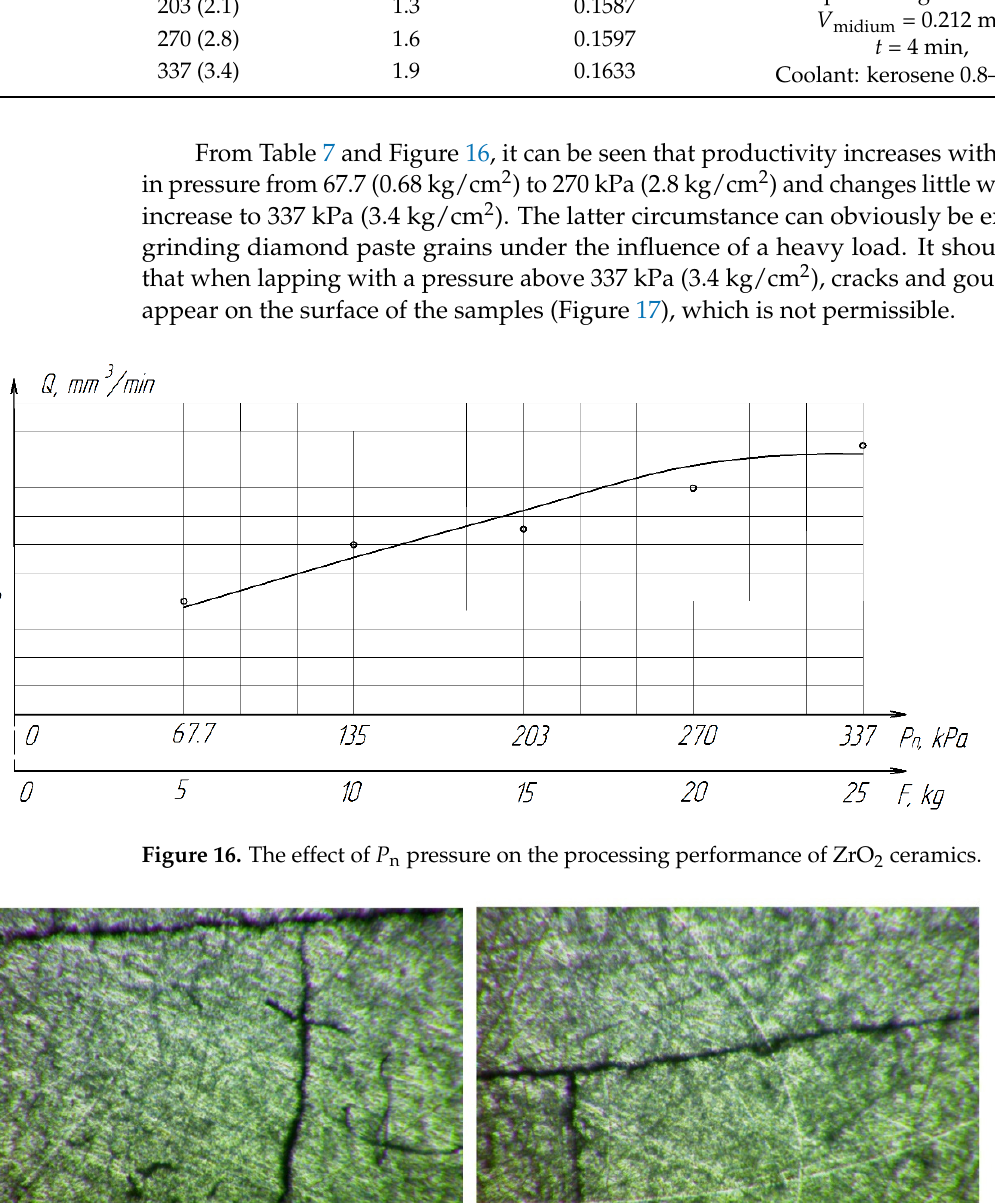
Figure 18. The effect of P n pressure on the roughness of the treated surface of ZrO 2 ceramics. Thus, it was found that the optimal pressure value for processing samples from ZrO 2 ceramics should be considered 203–270 kPa (2.1–2.8 kg/cm 2 ).